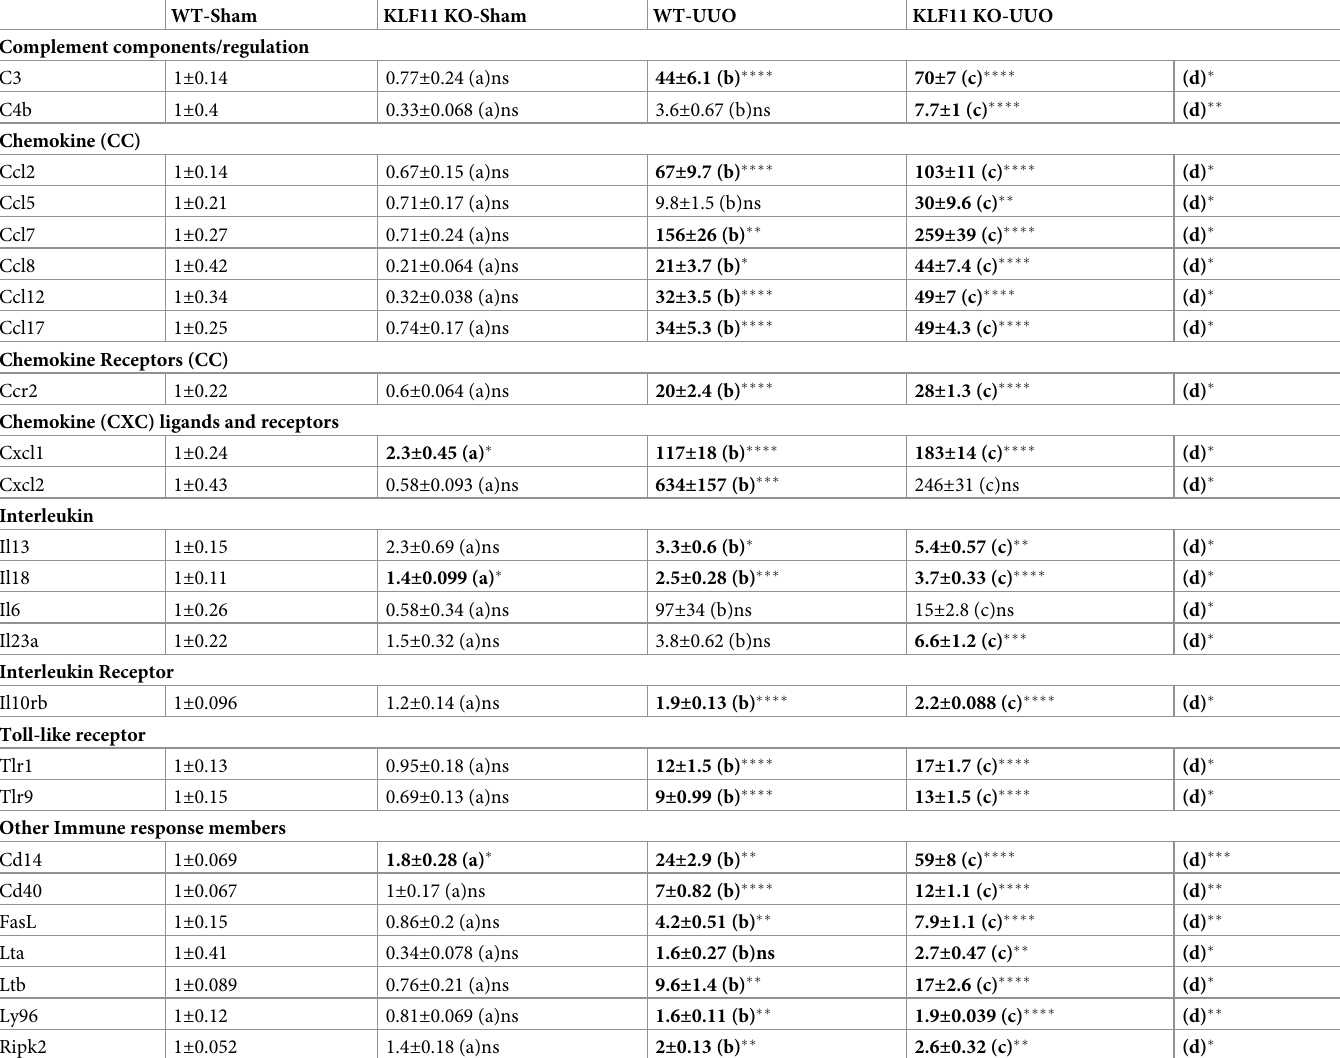
Gene expression analysis was performed employing the pathway Detect RNA array. The table showed the differentially expressed genes by RTPCR after 9 days of Surgery UUO. Statistical significance was determined by Student’s t-test. (A) KLF11 KO-UUO compared with WT-UUO. p values � 0.05 were considered as significant (GraphPad Software, La Jolla, CA). (B) List of genes differentially expressed between WT-Sham vs WT-UUO and KLF11 KO-Sham vs KLF11 KO-UUO but not differently expressed between WT-UUO vs KLF11 KO-UUO. Statistically significant values are highlighted in bold